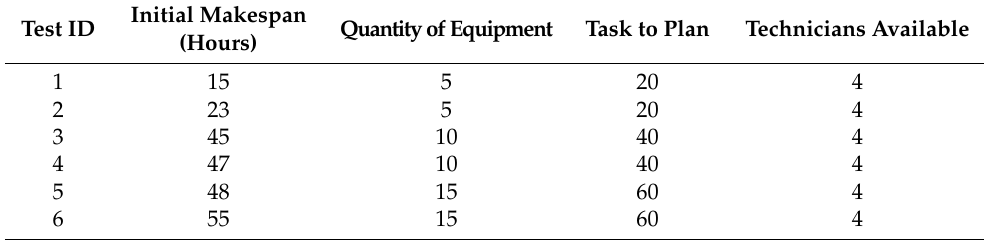
Table 3. Set of entry and expected times.